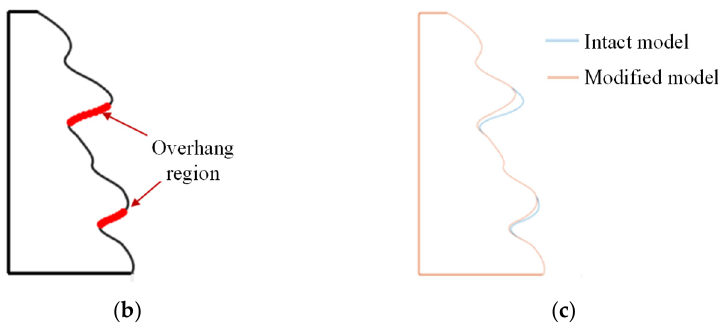
Figure 11. Curve-based model: ( a ) 3D model; ( b ) Base curve; ( c ) Modified curve.